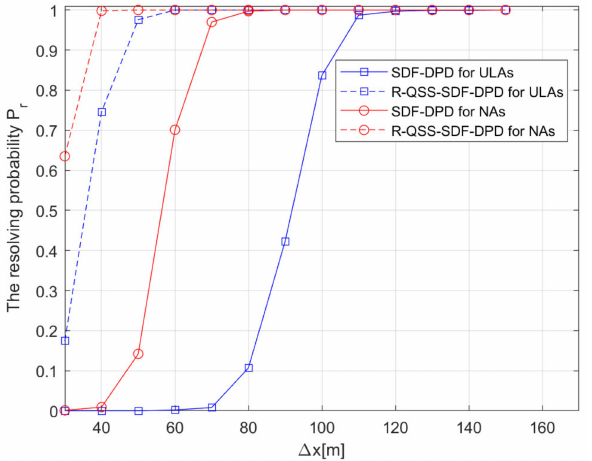
Figure 9. Comparison of SDF-DPD and R-QSS-SDF-DPD algorithms by resolving probability ver- sus ∆ x